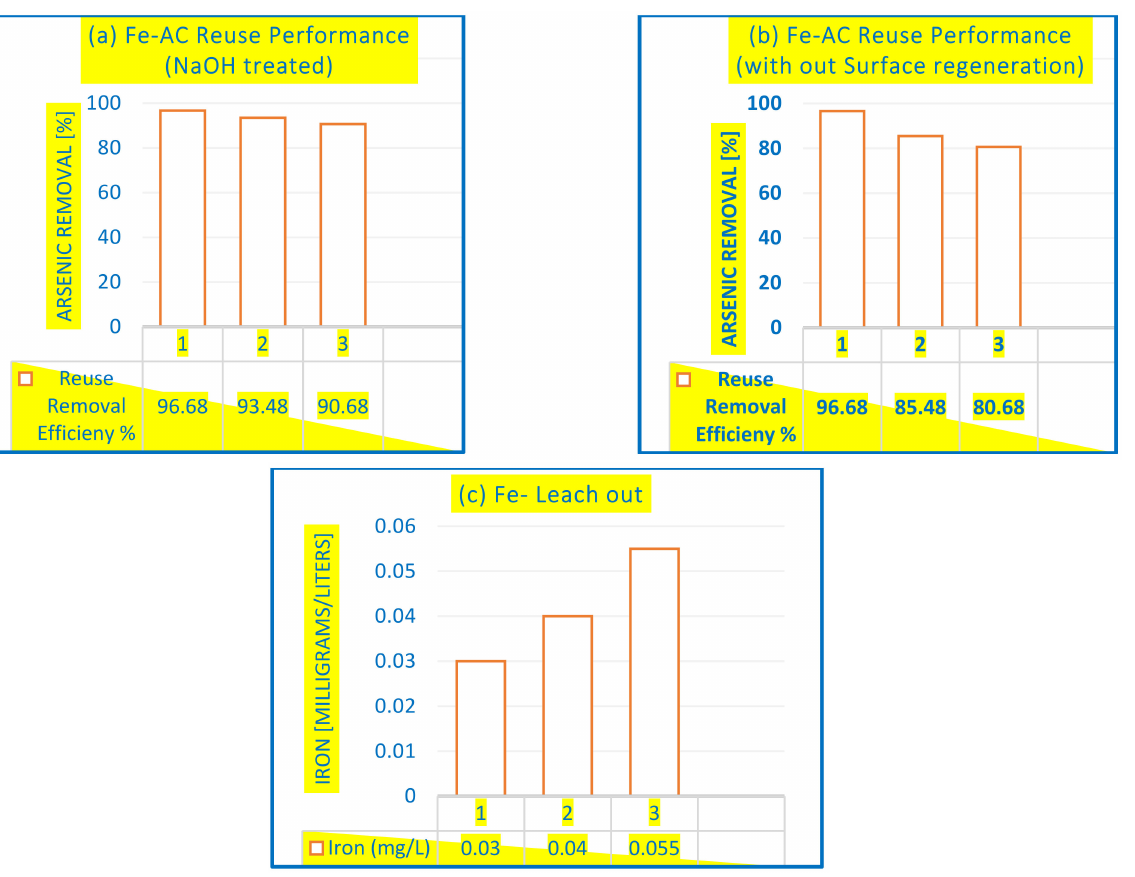
Figure 5. Reuse performance of catalytic ozonation processes (As = 68 ± 6 µ g/L; O 3 = 1.3 ± 0.2 mg/min; O 3 /Fe-AC = 10 g/L; pH = 7.6 ± 0.2; t = 30 min; volume = 1 L; T = 28 ± 2 ◦